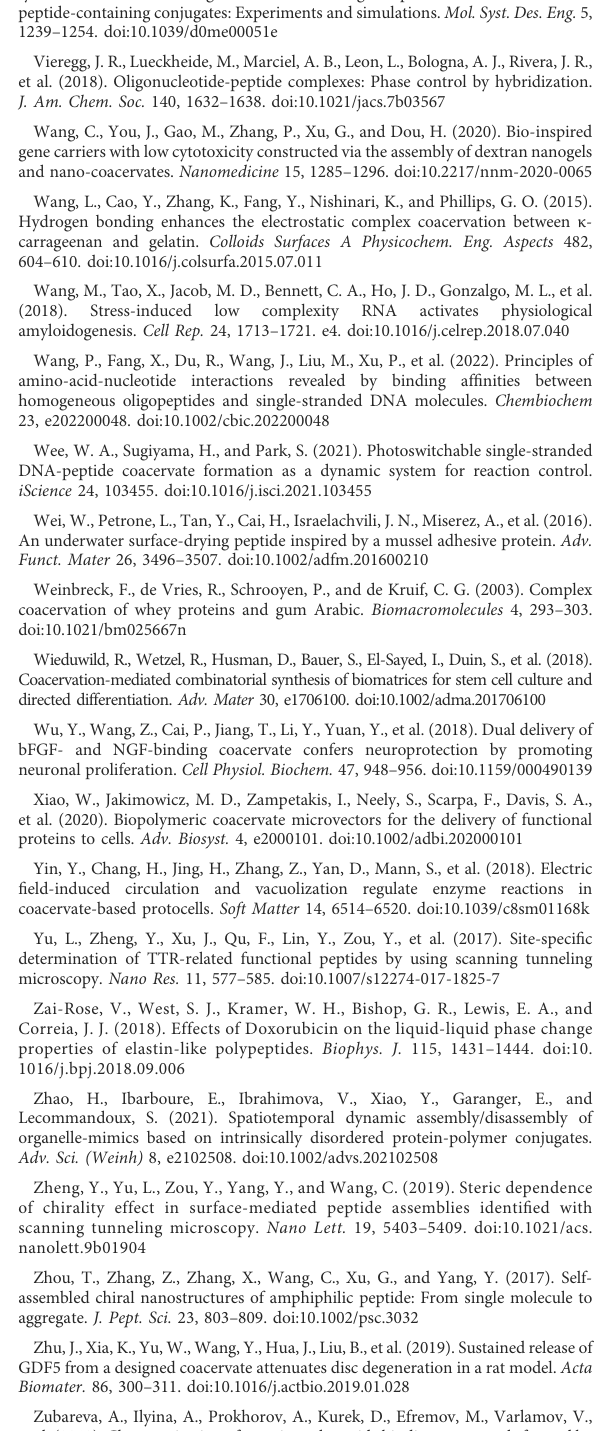
Tabandeh, S., and Leon, L. (2019). Engineering peptide-based polyelectrolyte complexes with increased hydrophobicity. Molecules 24, 868. doi:10.3390/